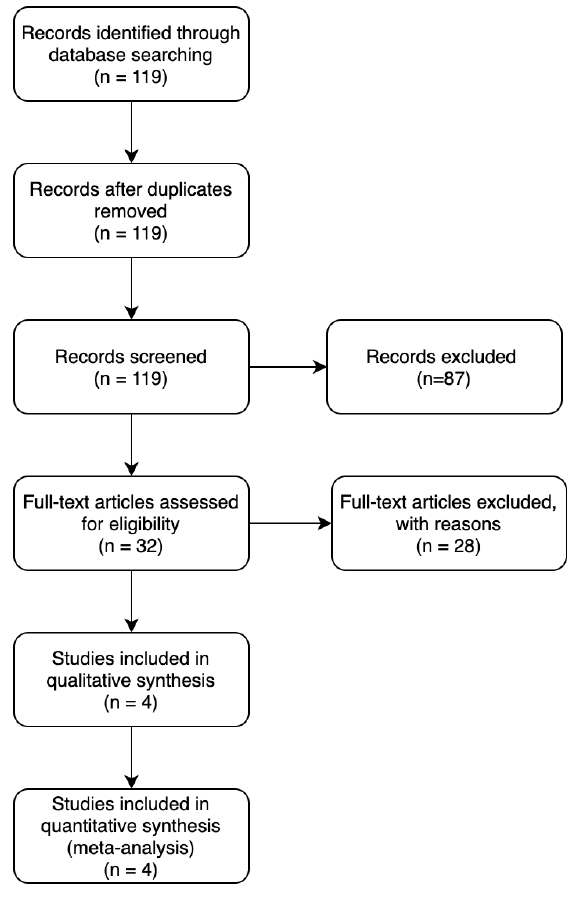
Figure 4. Scientific studies